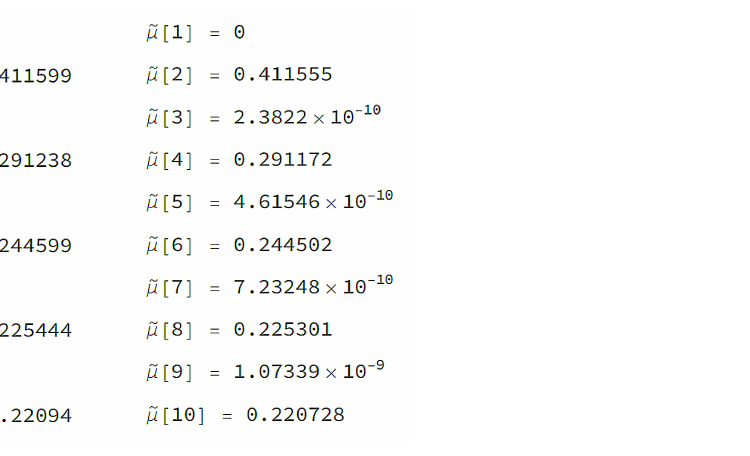
Figure 17. Moments of F ( t ) in (31) as computed using the G-KQR ( left ) and the proposed Bell’s polynomial approximation ( right )